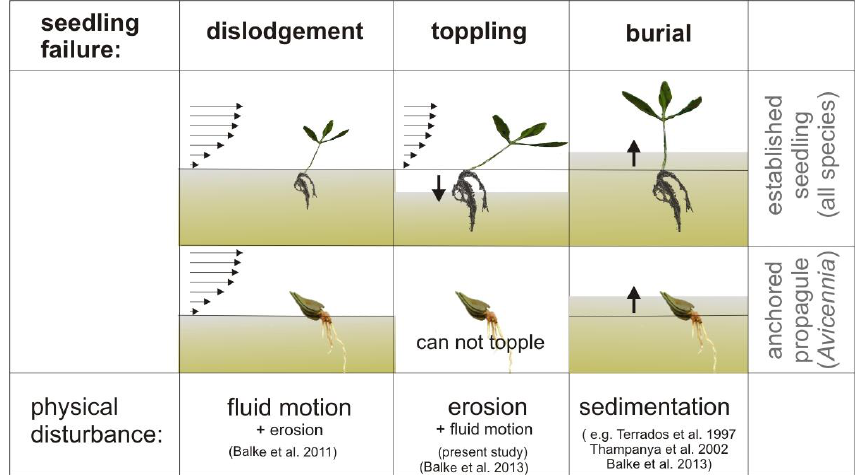
Fig. 5. Summary of type of seedling failure related to physical disturbance processes comparing effects on just anchored propagules of Avicennia spp. (based on Balke et al., 2011) with established pioneer seedlings ( Avicennia spp. and Sonneratia spp.), based on this study and cited literature. Dislodgement occurs due to hydrodynamic drag forces and is especially relevant to recently anchored (viviparous) propagules (here Avicennia spp.) with short roots. Erosion around the roots can increase the susceptibility to dislodgement. Bigger seedlings facing erosion will fail before they get dislodged as remaining roots in the soil are not strong enough to support the seedling to stand upright, resulting in toppling failure. Fluid motion exerts a force on the seedling, decreasing the resistance to toppling (i.e. wave in flume study). New layers of sediment can get deposited and smother established seedlings and anchored propagules or entirely bury